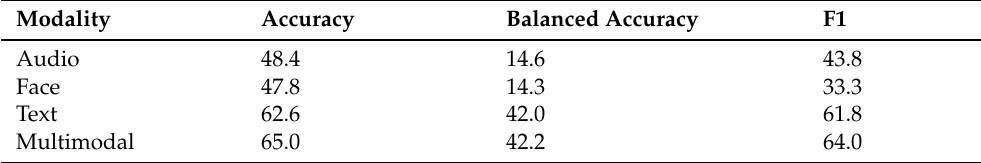
Table 2. The overall classification results of the single modality and multimodal methods (Unit = %).